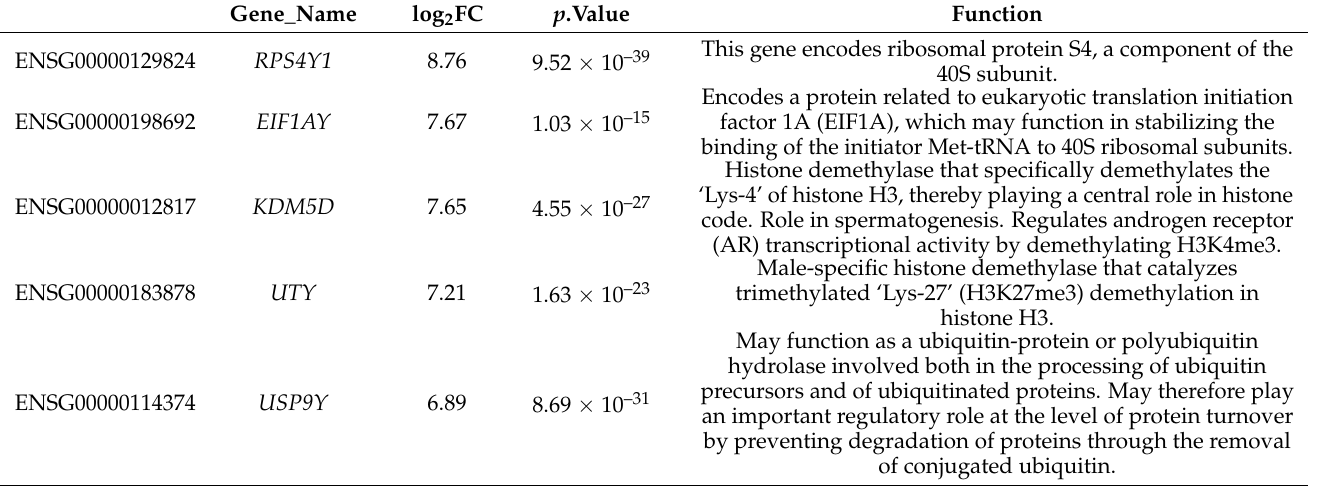
Table 2. List of DE RNAs ranked according to their absolute value of fold change (log 2 FC). The gene’s p .value is also reported, along with their function, as described in the STRING or UniProtKB